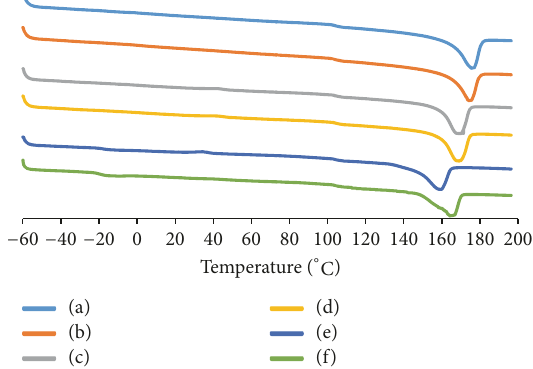
Figure 5: Thermograms obtained during the second run of differ- ential scanning calorimetry (DSC) of the poly-R-hydroxyalkanoates (PHAs) produced by the addition of avocado oil at (a) 0 (control), (b) 5, (c) 10, (d) 15, (e) 20, and (f) 25 percent